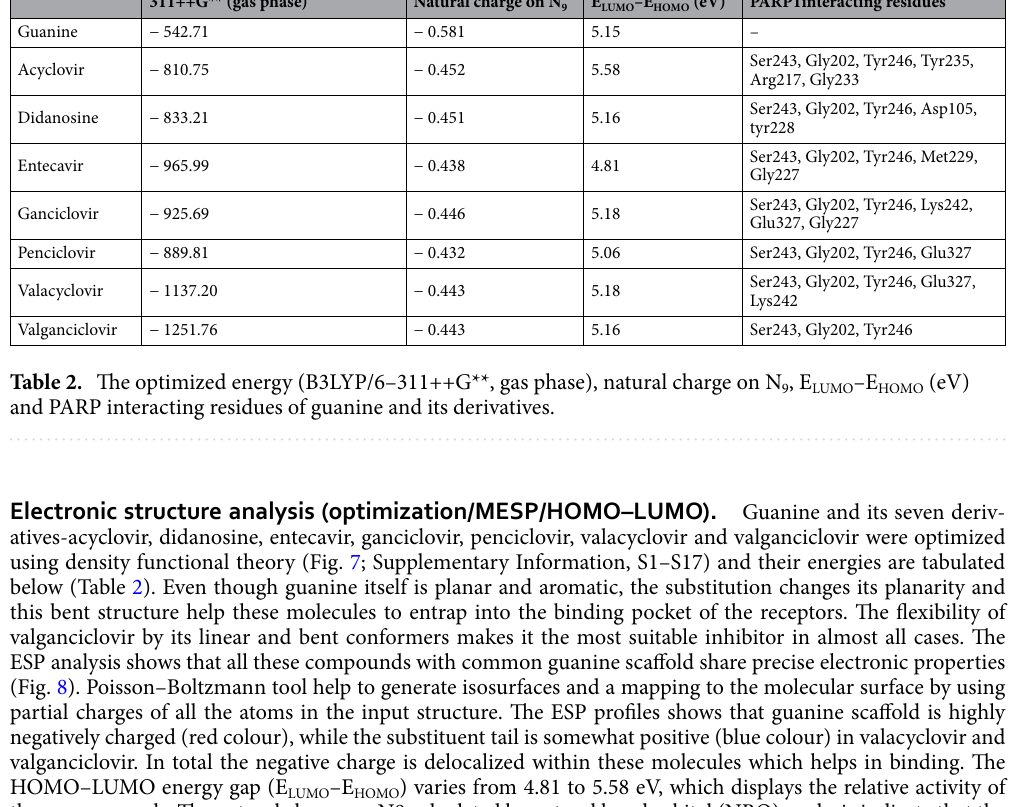
Figure 7. Optimized geometries (B3LYP/6-311++G**) of the guanine ( 1 ) and its seven derivatives—acyclovir ( 1a ), didanosine ( 1b ), entecavir ( 1c ), ganciclovir ( 1d ), penciclovir ( 1e ), valacyclovir ( 1f ) and valganciclovir ( 1g ) (generated by Chemcraft 1.8 GUI) 37 . Optimized energy B3LYP/6- 311++G** (gas phase) Natural charge on N 9 E LUMO –E HOMO (eV) PARP1interacting